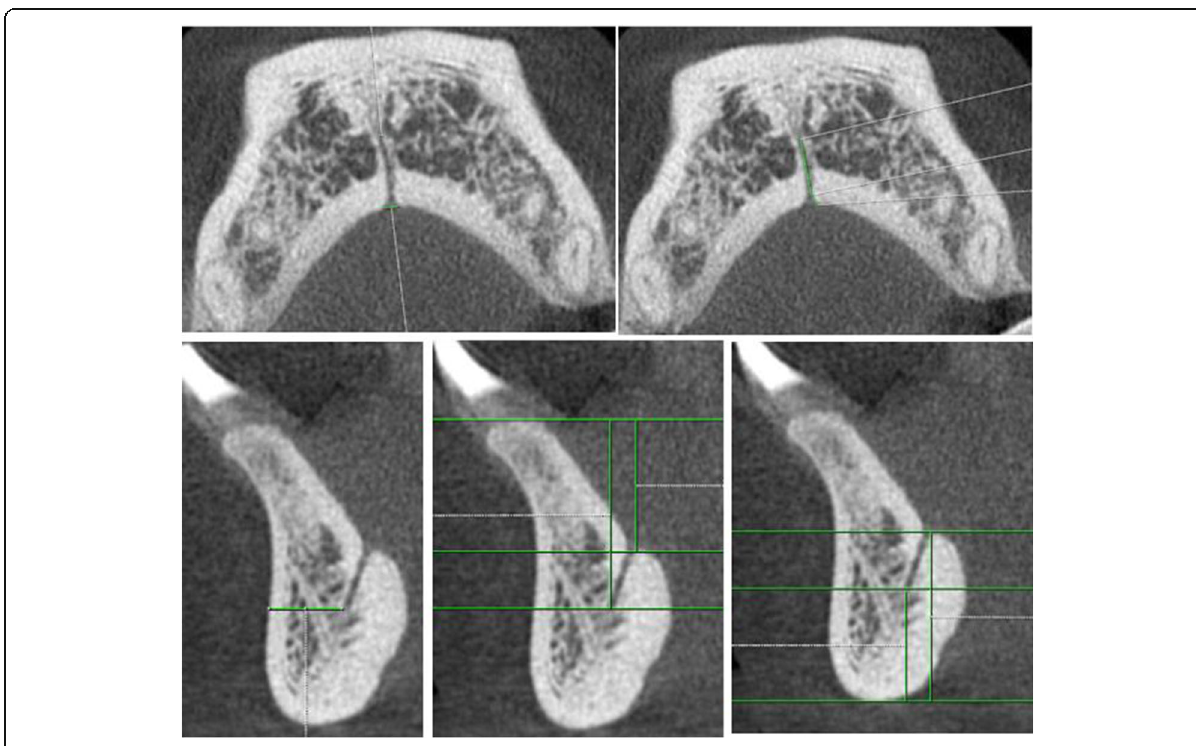
Fig. 5 CBCT measurements in 40-year-old female